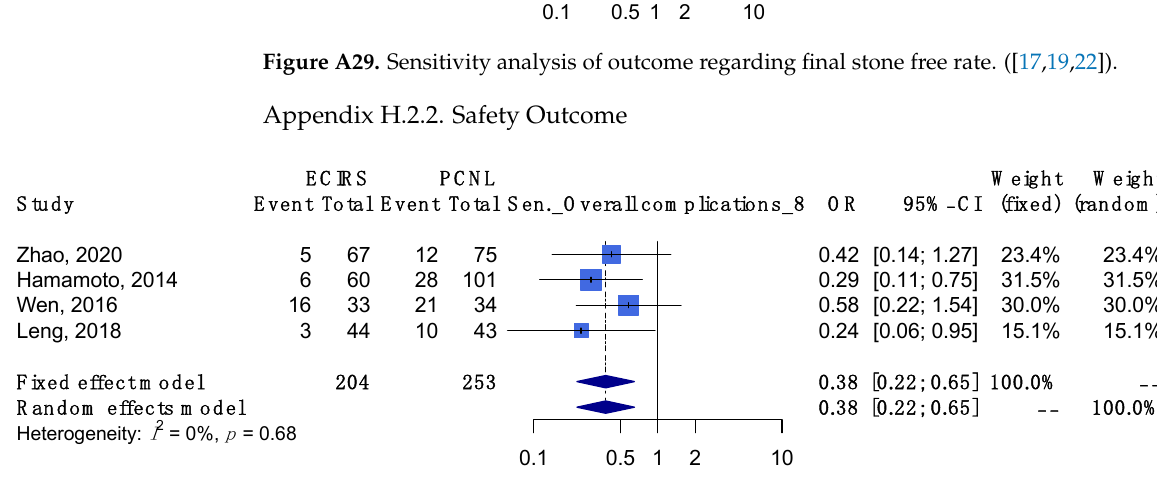
Figure A29. Sensitivity analysis of outcome regarding final stone free rate. ([17,19,22])